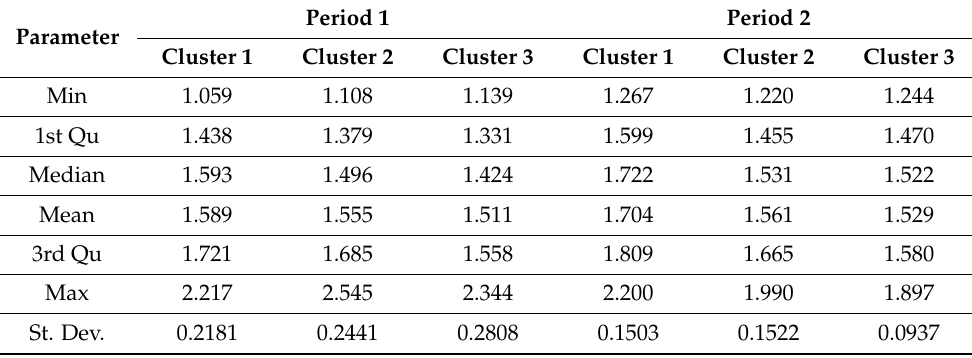
Table 19. Descriptive statistics of the THDu in phase L2 at the tested measuring